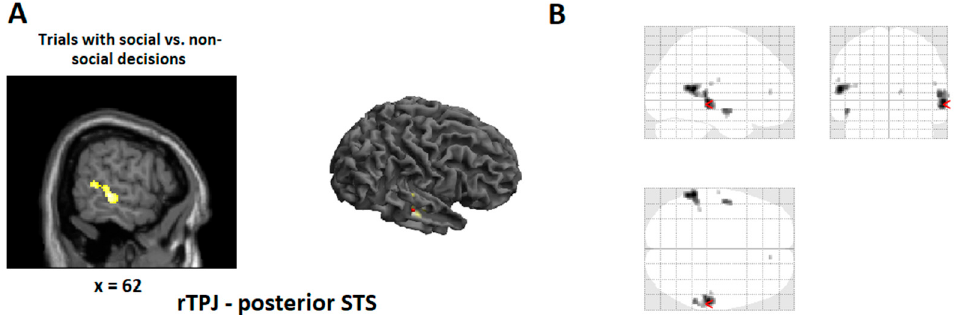
Figure 3. Statistical maps showing brain activation for trials with social relative to non-social decisions. ( A ): Areas of significant fMRI signal change are shown as color overlays on the T1-MNI reference brain (at p < 0.005, uncorrected, for picture purpose only). ( B ): Glass brain depicting same contrast as in A (at p < 0.005, uncorrected). Even at the very lenient threshold of p < 0.005 (uncorrected) we found no anterior insula activation.